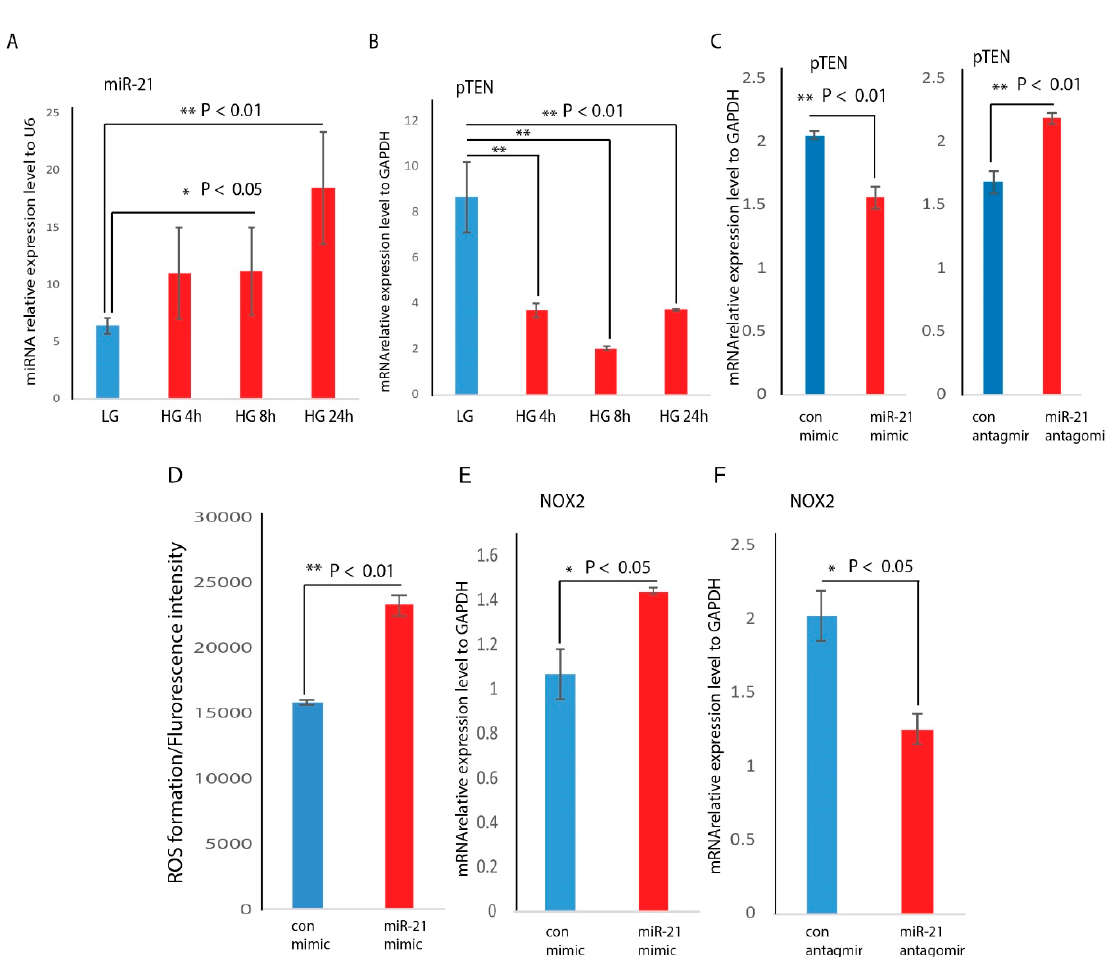
Figure 5. Hyperglycemia induces miR-21 and reduces pTEN expression in macrophage cells. ( A ) RAW cells were treated with high glucose conditions (25 mM D-glucose) for 4, 8, and 24 h. Compared to normal glucose treated RAW cells, miR-21 was significantly induced by high glucose (HG) in a time-dependent manner by real-time PCR analysis (mean + SD, n = 3 per group); ( B ) RAW cells were treated with high glucose conditions (25 mM D-glucose) for 4, 8, and 24 h. Compared to normal glucose-treated RAW cells, pTEN was significantly reduced by HG in a time-dependent manner (mean + SD, n = 3 per group). Overexpression or knockdown of miR-21 RNA abundance was achieved by miR-21 mimic or antagomir transfection in macrophage; ( C ) real-time PCR analysis on pTEN mRNA abundance under the condition of overexpression or knockdown of miR-21 RNA abundance; ( D ) ROS production between control-mimic- and miR-21-mimic-treated RAW cells using a DCFDA / H2DCFDA-cellular ROS assay. The data is represented as mean ± SD, n = 5 per treatment group. NOX2 was significantly induced by miR-21 mimic ( E ), and reduced by miR-21 antagomir ( F ) by real-time PCR analysis (mean + SD, n = 3 per group, * p < 0.05).